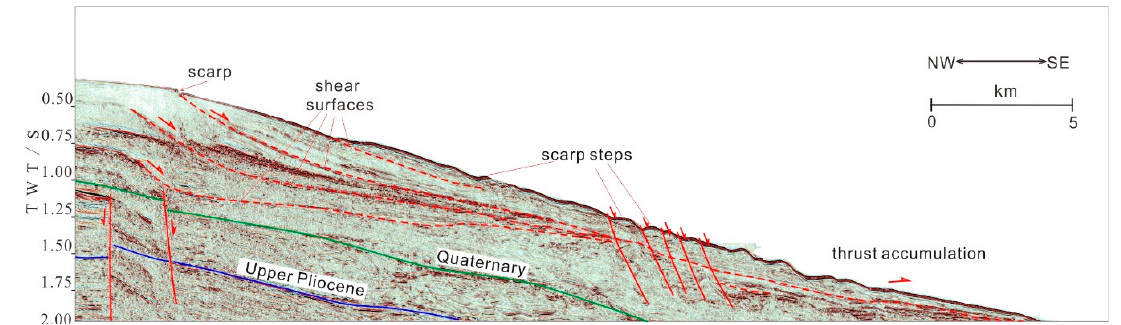
Figure 7. Seismic reflection of Line 6 is a landslide induced by erosion.